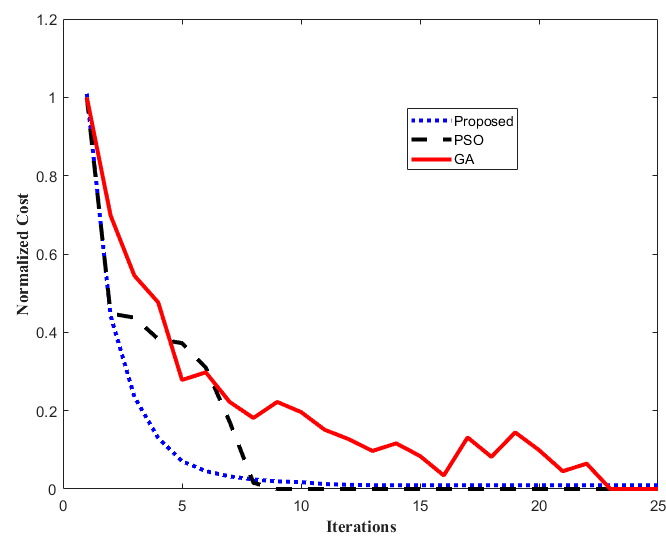
Figure 11. Convergence time.